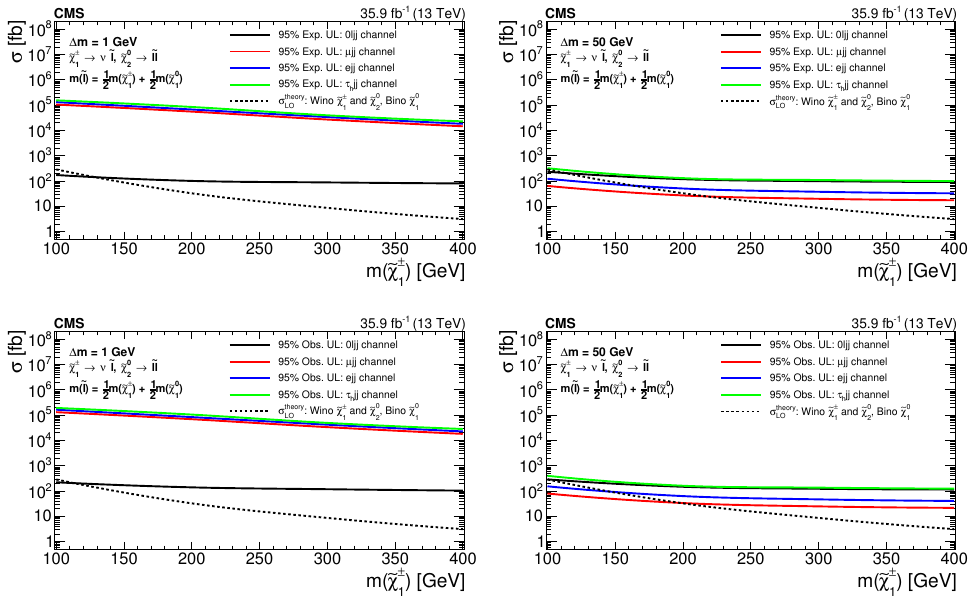
Figure 4 . Combined 95% CL UL on the cross section as a function of m correspond to (cid:1) m = 1 GeV (left) and (cid:1) m = 50 GeV (right) mass gaps between the chargino and the lightest neutralino in the light slepton model. The top row shows the expected limits, and the bottom row shows the observed